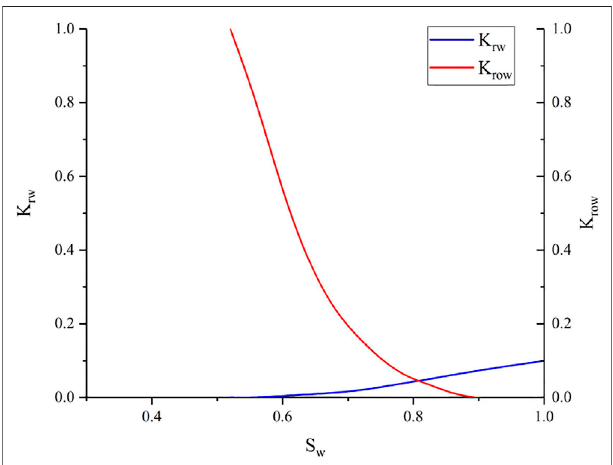
FIGURE 6 | Relative permeability curves of oil-water two-phase.